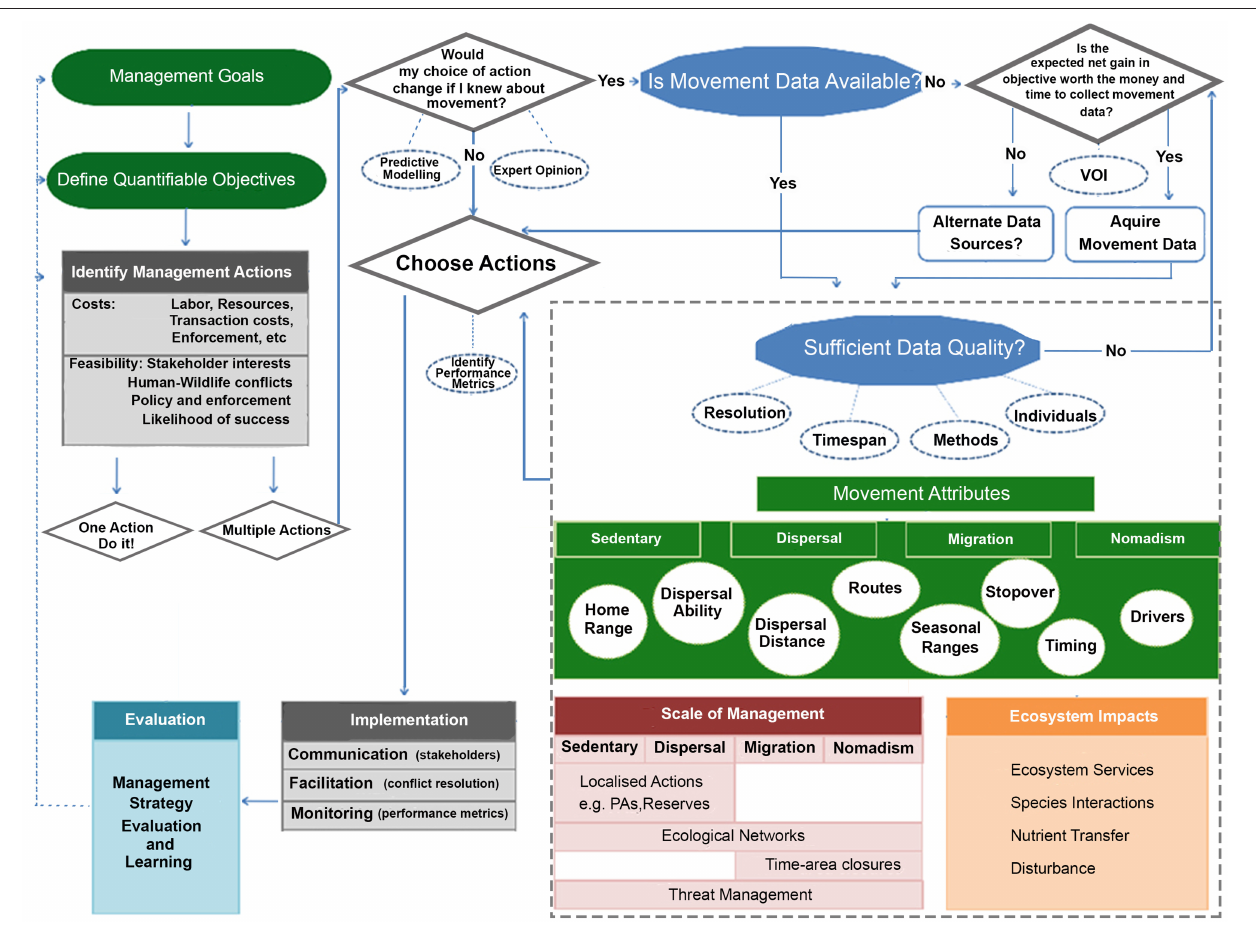
FIGURE 1 | The Movement Management framework, adapted from Allen and Singh (2016), provides a workflow for integrating movement ecology into conservation decision-making. Notable changes include steps to define quantifiable objectives, and identify and choose between management actions. Elements in and attached to diamonds are new additions to the workflow reflecting a focus of the value of information to inform decisions. Characteristics of movement data, such as quality, attributes, scale, and impacts aid the selection of actions in time and